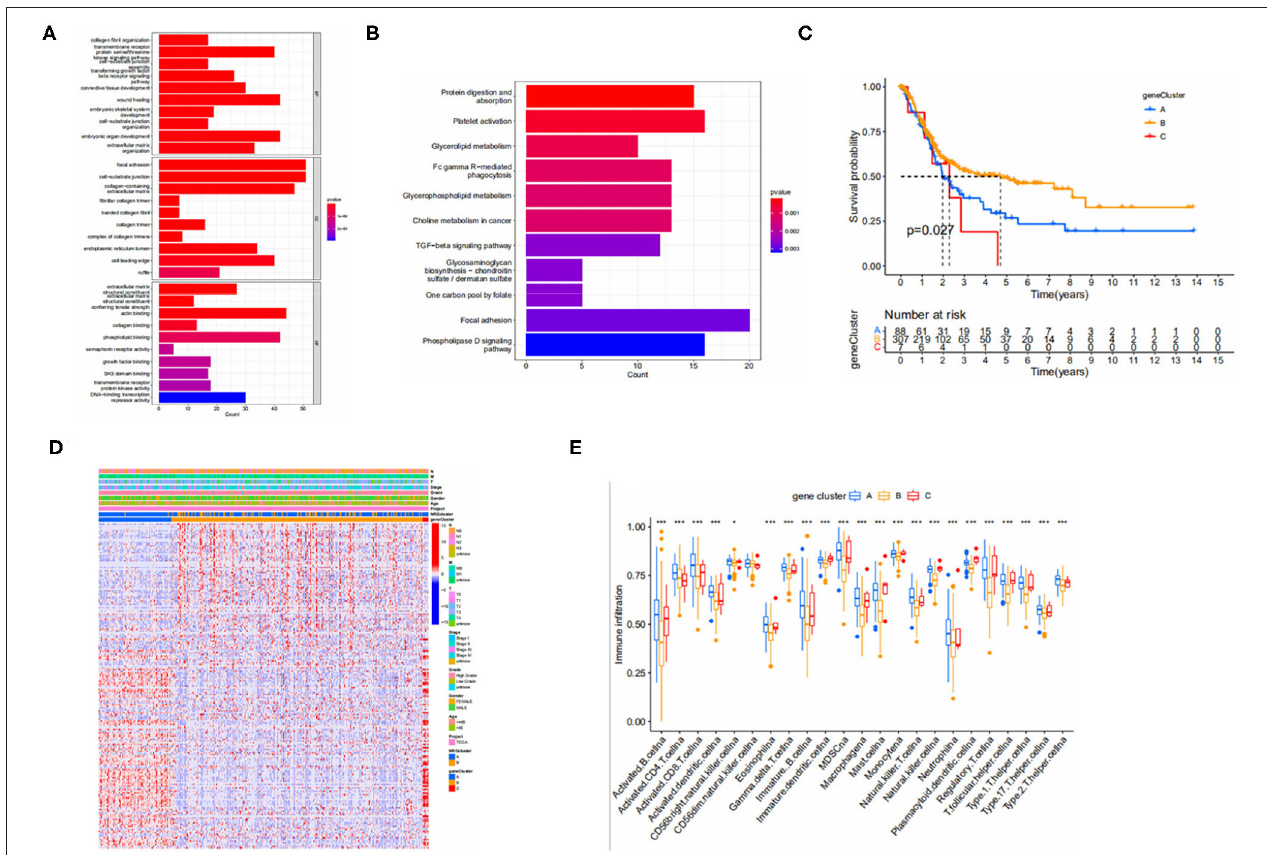
FIGURE 3 | (A,B) GO and KEGG enrichment analyses of DEGs among two necroptosis-associated subtypes. (GO, Gene Ontology; KEGG, Kyoto Encyclopedia of Genes and Genomes). (C) Kaplan-Meier analysis curves for the three gene subtypes. (D) Relationships between clinicopathologic features and the three gene subtypes. (E) Immune infiltration between gene